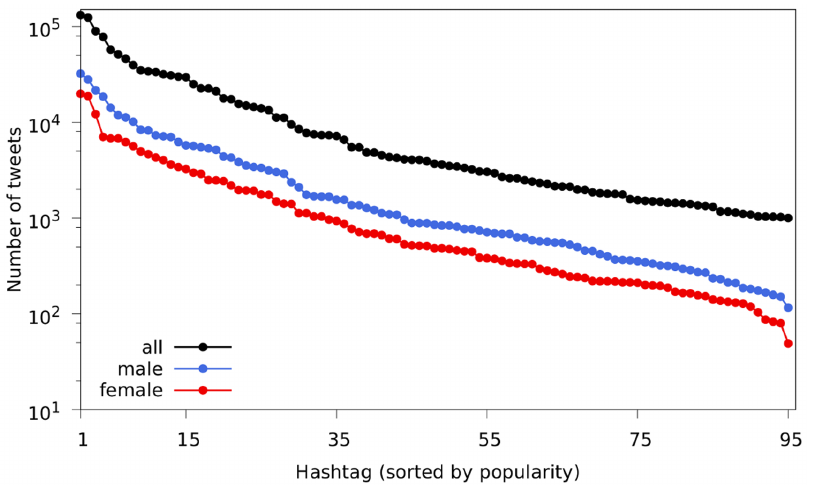
Figure 3. Frequency of usage of the hashtags vs. their positions in a popularity ranking. As shown in previous investigations [16], a few hashtags are very popular, while most of them are not widely employed by network members.